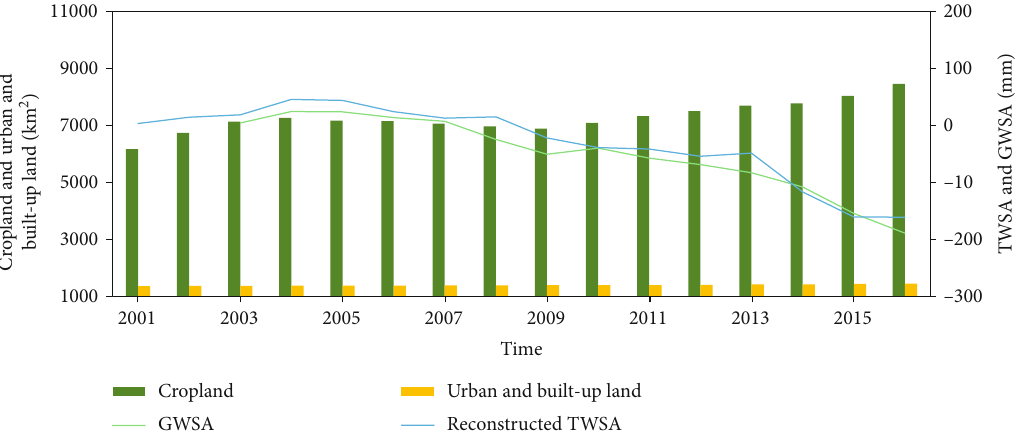
Figure 6: The yearly time-series data of cropland, urban and built-up land, GWSA, and reconstructed